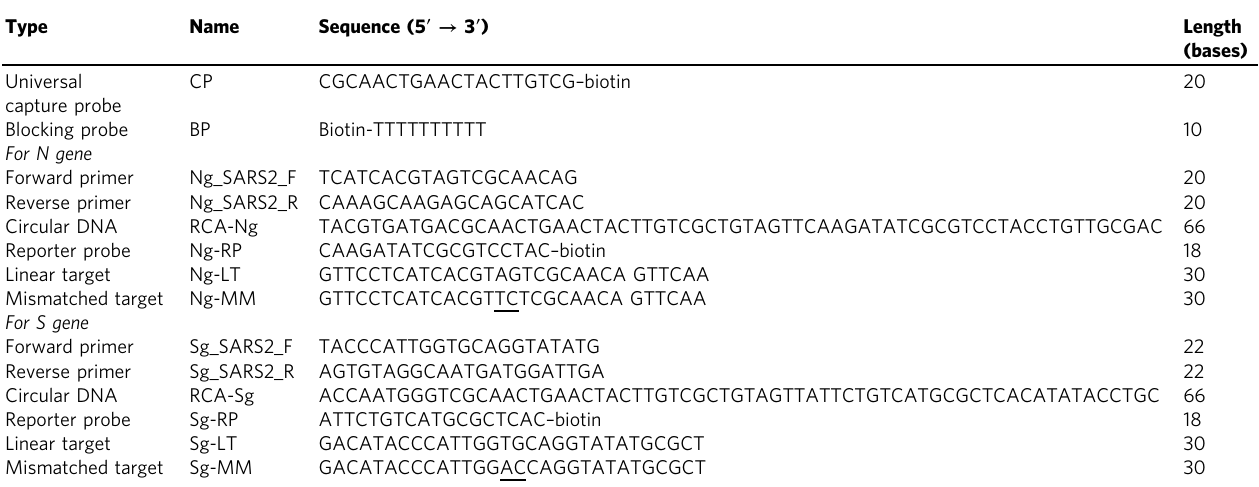
Table 2 Sequences of circular DNA, primers, and probes used in this